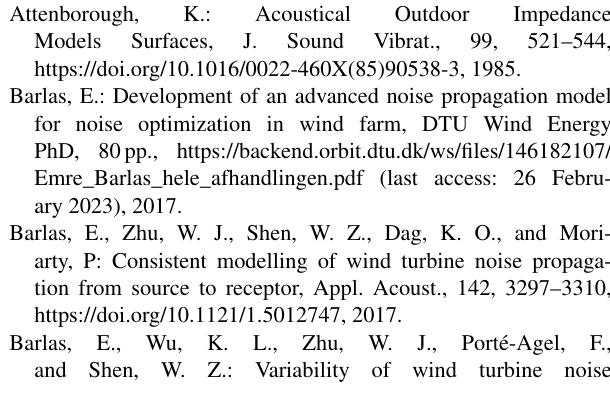
Code availability. Topfarm is an open source optimization